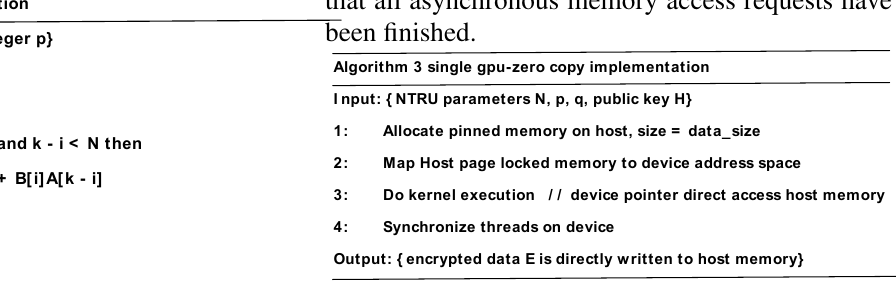
Fig. 3. single gpu-zero copy